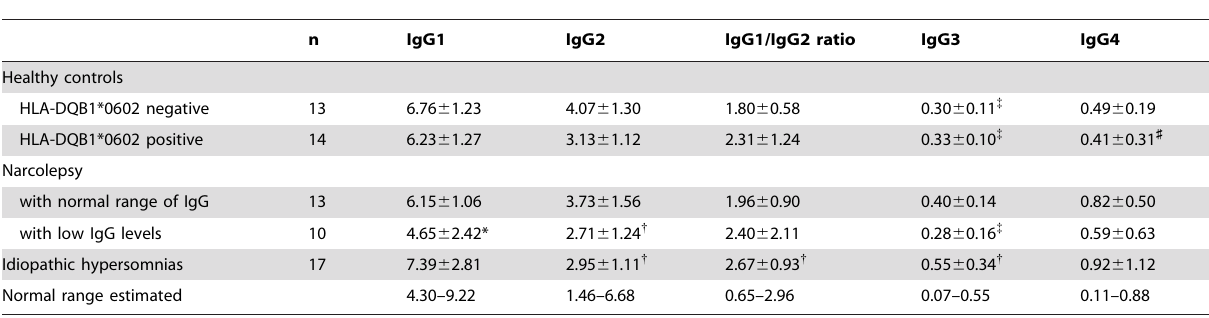
Table 2. Four IgG subclasses (mg/ml).